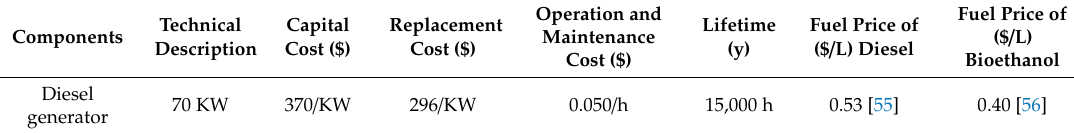
Table 9. Techno-economic parameters considered for the simulation of diesel generator.